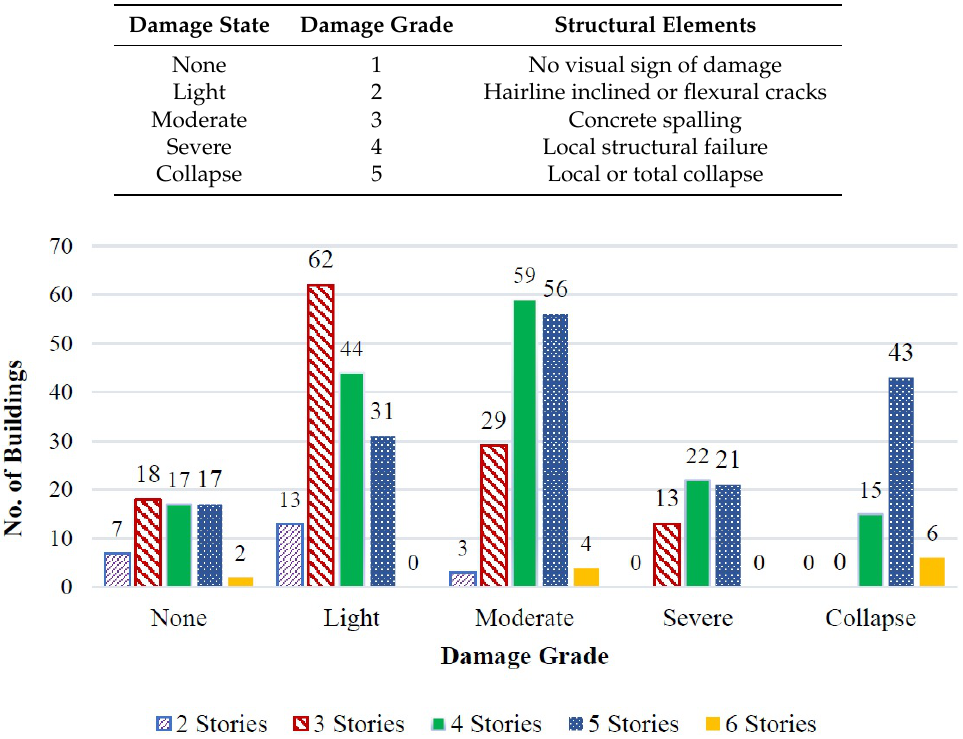
Figure 4. Damage Distribution According to the Number of Stories (adopted from [50]).